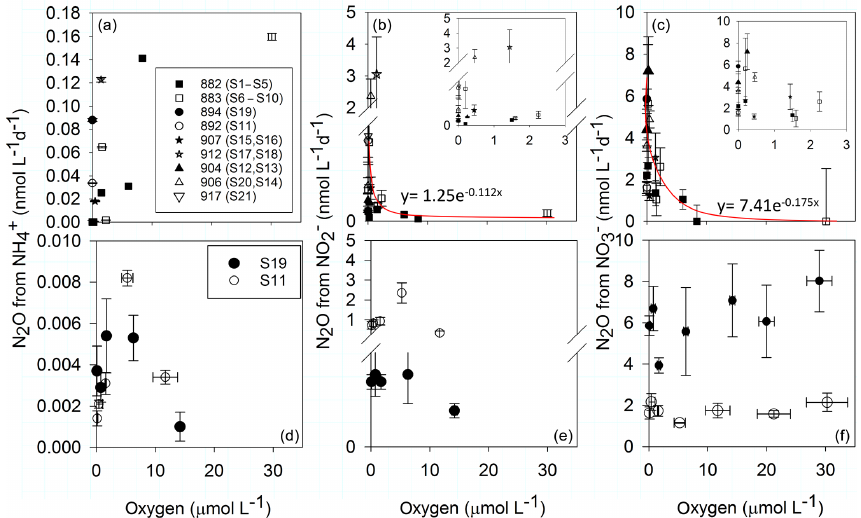
Figure 4. O 2 dependence of N 2 O production rates from NH + along a natural O 2 gradient from all stations. Panels (b) and (c) are additionally zoomed in to oxygen concentrations below 5µmolL − 1 . Lower panels (d–f) show N 2 O production in manipulated O 2 experiments with water from the oxic–anoxic interface from slope station 892 (S11, 0µmolL − 1 O 2 , 145m) and shelf station 894 (S19, 0µmolL − 1 , 120m). Note the different scale for N 2 O production rates from NH + Vertical error bars represent ± standard error ( n = 5 per time course). Horizontal error bars represent ± standard error of measured O 2 over the time of incubations ( n = 6).